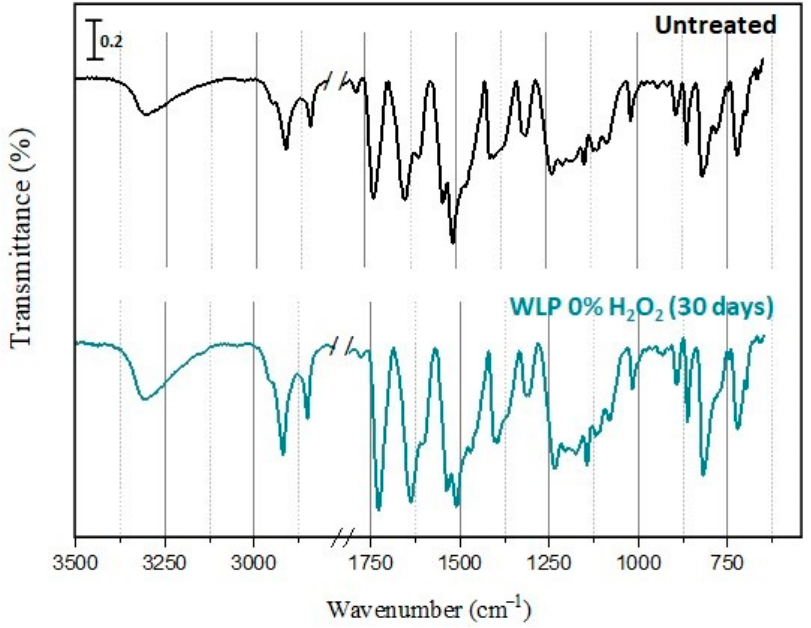
Figure 6. FTIR/ATR spectra of untreated sample and WLP 0% of H 2 O 2 exposed for 30